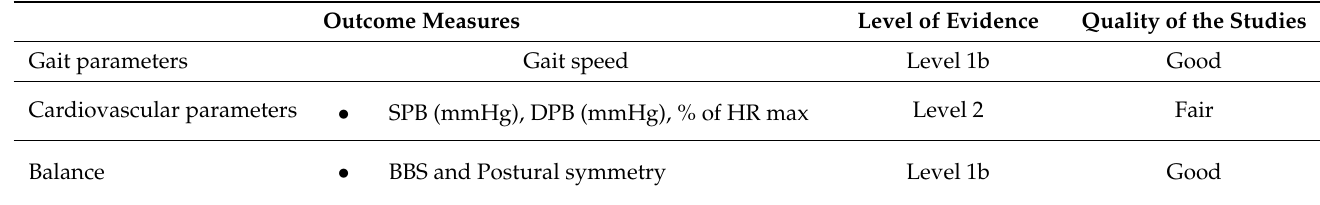
Table 4. Level of evidence for outcome measures included in the